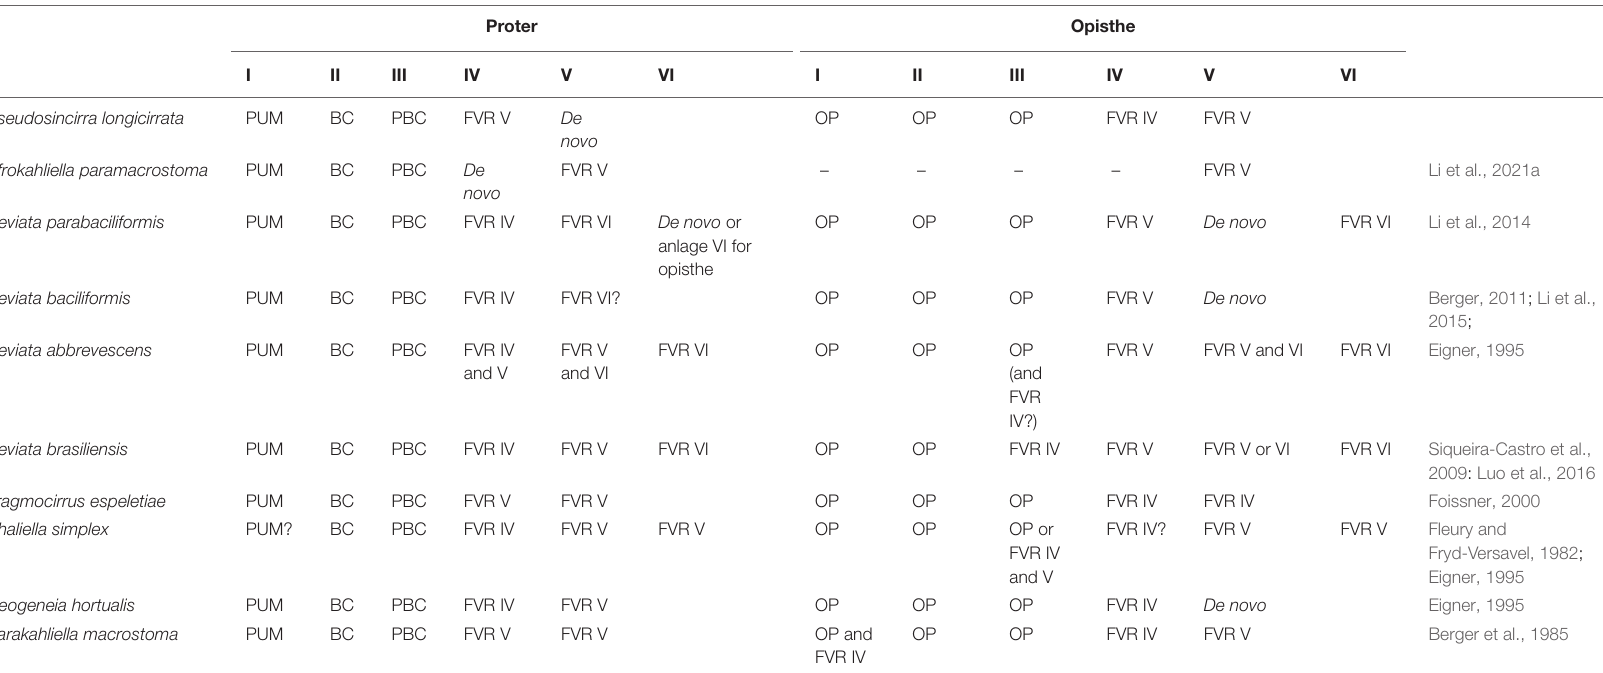
TABLE 2 | Morphogenetic comparison of the Chinese population of Pseudosincirra longicirrata nov. gen. and nov. comb. with similar species showing the origin of frontoventral-transverse cirral anlagen.